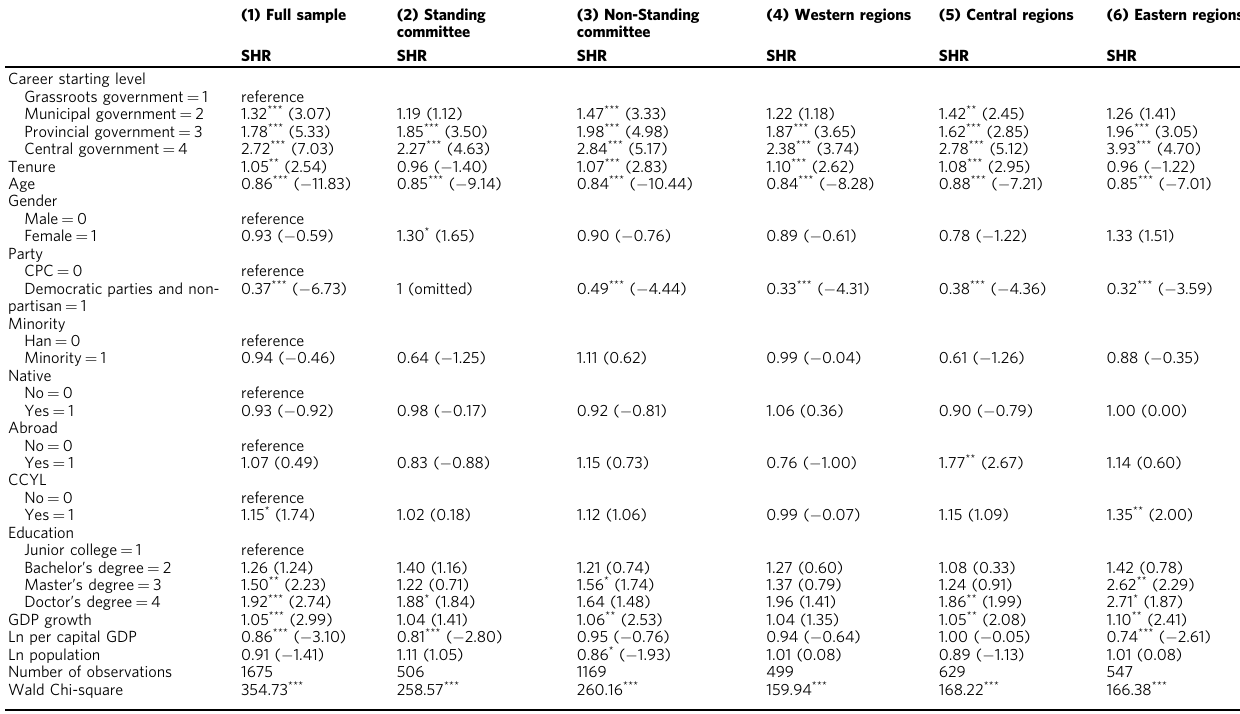
Table 2 The competing risk regression results estimating the effect of different career starting levels on political promotion.